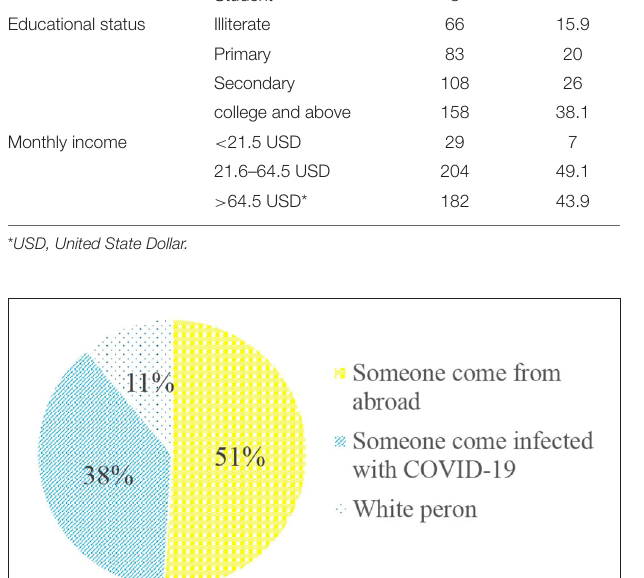
were from urban areas. The mean age of the participants was 32.83 ± 8.78 SD. The majority of the participants were male [268 (64.6%)] and government employees [113 (27.2%)]. Regarding their educational status, 66 (15.9%) cannot read and write and 158 (38.1%) have attended college and above ( Table 1